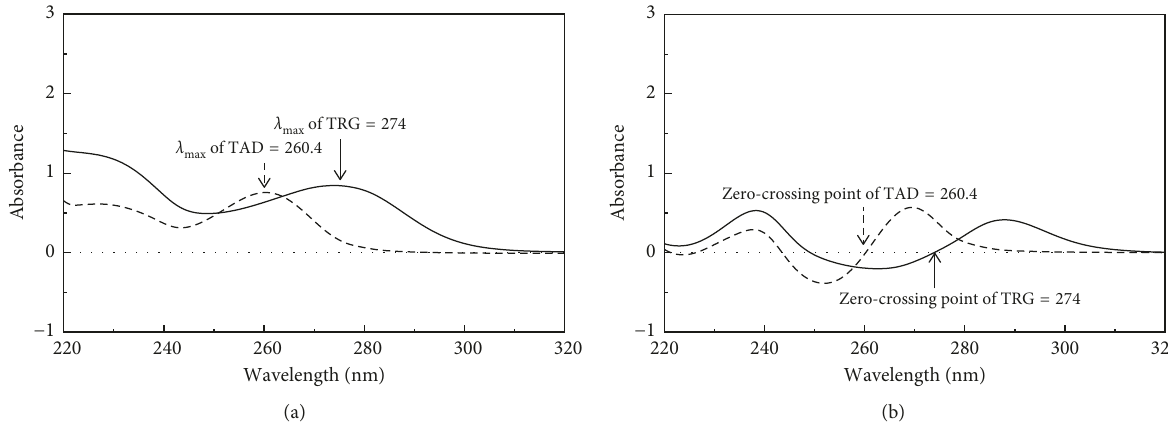
Figure 2: Overlay of the absorption spectra (a) and first-derivative spectra (b) of TRG 30 µ g/mL (solid line) and TAD 15 µ g/mL (dashed line), using methanol as a